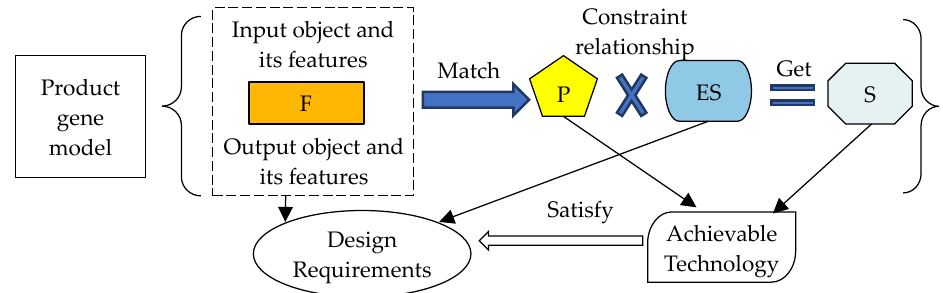
Figure 9. Relationship between elements within the product gene model.